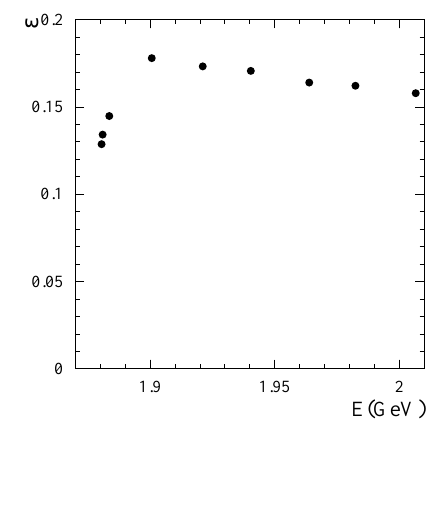
Figure 1. The detection e ffi ciency ε deter- mined using MC simulation.